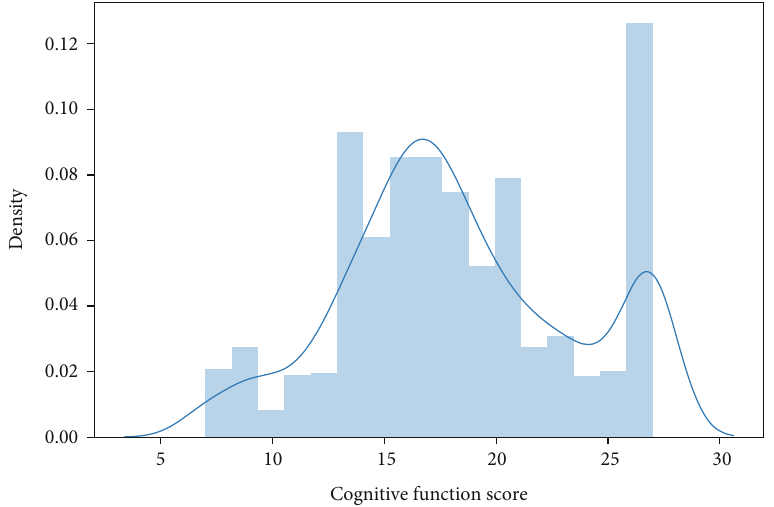
Figure 1: The histogram of cognitive function